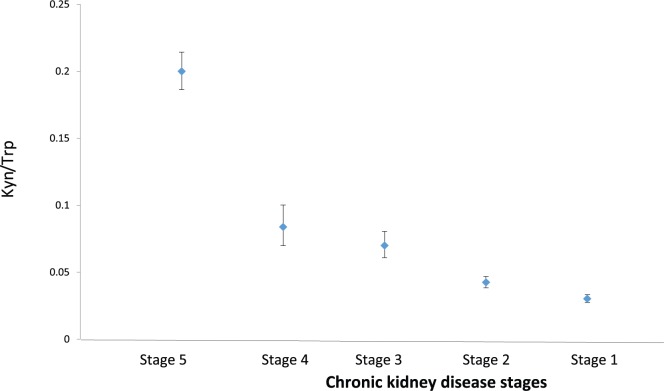
Kynurenine/tryptophan ratio by stages of chronic kidney disease.Data are geometric mean and 95% confidence interval.Statistical difference between stage 1 and stage 2: P = 0.03; stage 2 and stage 3: P = 0.003; stage 3 and stage 4: P = 0.43; stage 4 and stage 5: P < 0.0001.